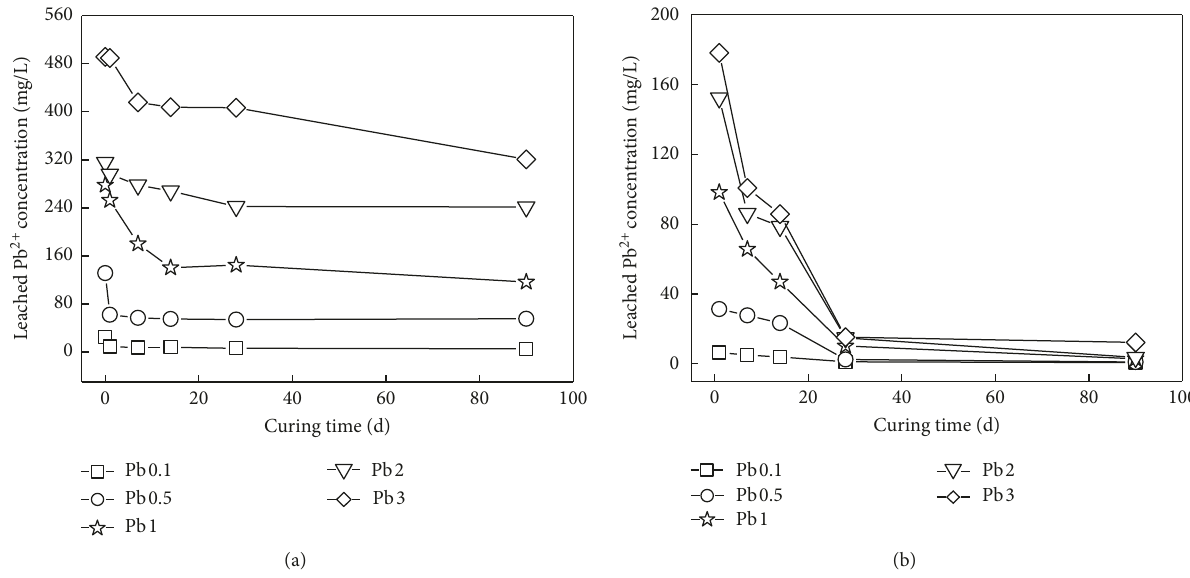
Figure 7: Evolutions of the leached Pb 2+ concentration with the curing time of the specimen. Alkaline residue contents of (a) 10% and (b) 30%.